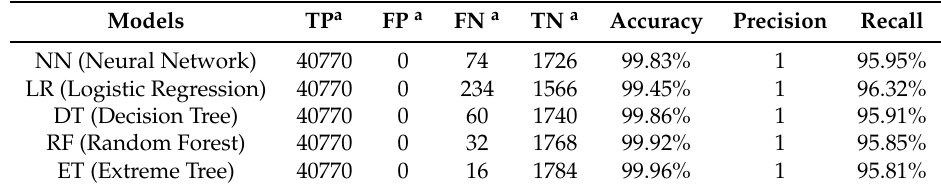
Table 3. The detection results of five